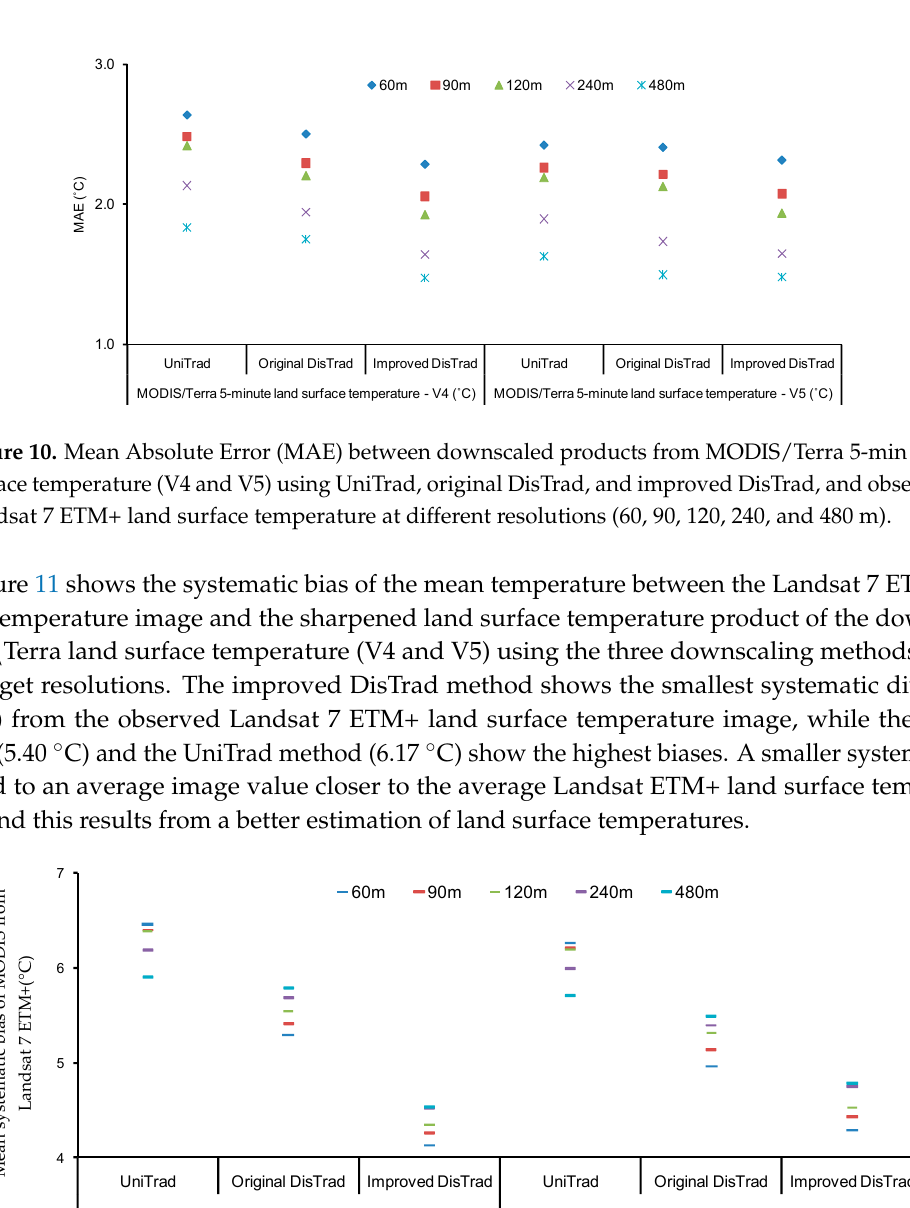
Figure 11. Mean temperature systematic bias of the downscaled products from MODIS\Terra 5-min land surface temperature (V4 and V5) using the UniTrad, original DisTrad, and Improved DisTrad compared to the observed Landsat 7 ETM+ land surface temperature.